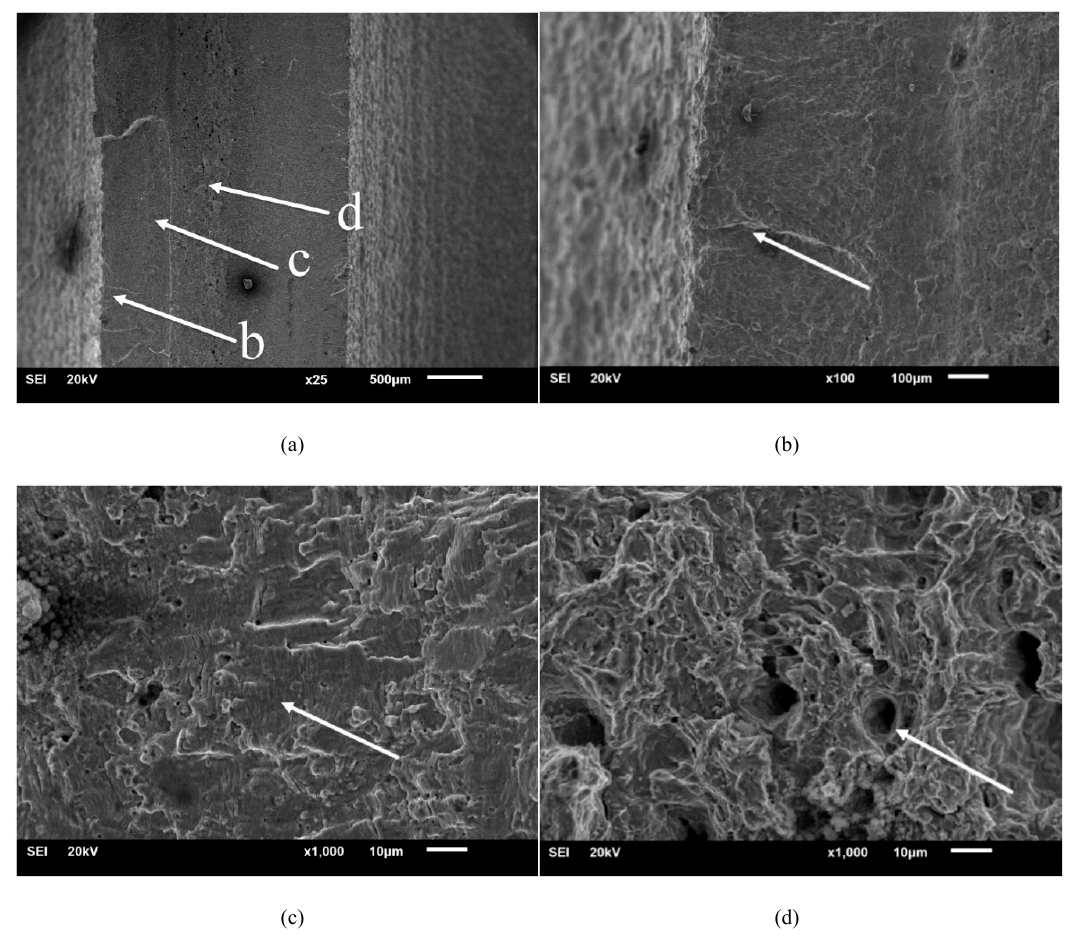
Figure 8. Fracture morphology of the U_1 specimen. ( a ) Macroscopic fracture, ( b ) crack source zone, ( c ) crack propagation zone, and ( d ) instantaneous fracture zone.